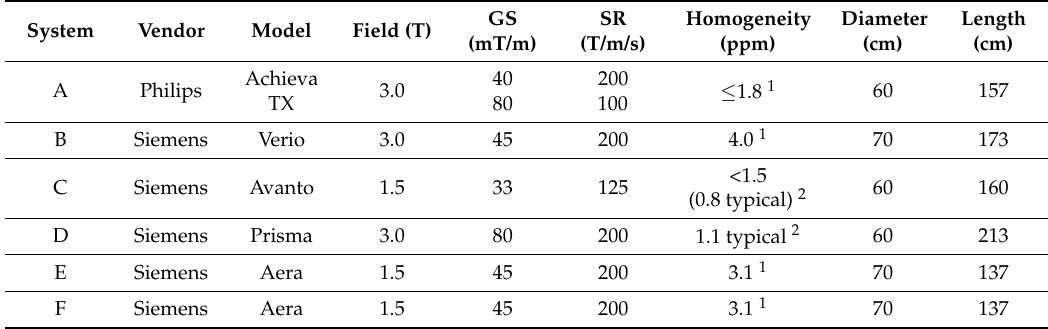
Table 1. Details of scanners used in this study. Parameters taken from the vendors’ manuals (GS = gradient strength, SR = slew rate).